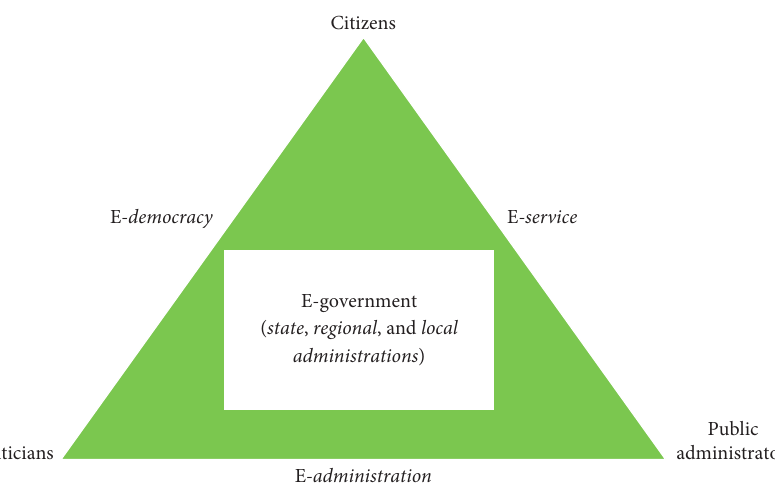
Figure 1: E-government relationships model (source: